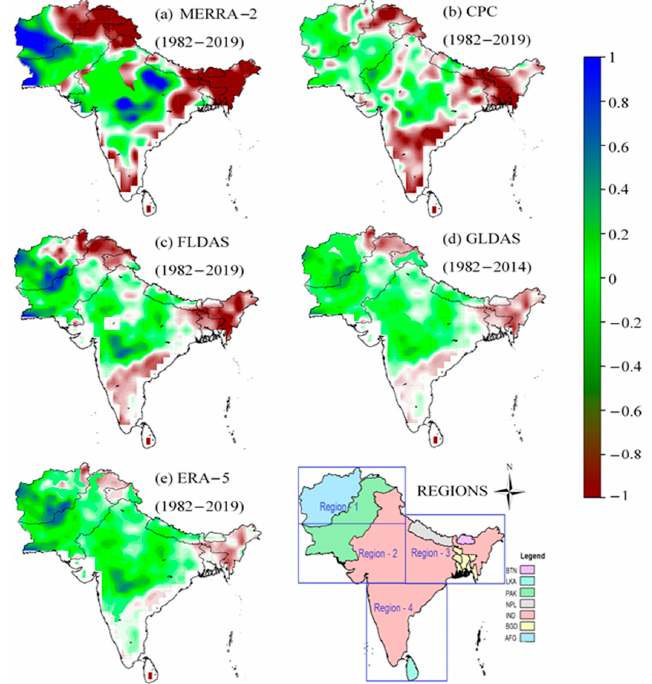
Figure 2. ( a – e ) The spatial patterns of different standardized soil moisture index (SSMI) over South Asia. These patterns have been scaled in the form of ±1, hence temporal assessment indicates the genuine magnitude (Figure 4) of SSMI, where spatial patterns have values near ±1. Remote Sens. 2021 , 13 , x FOR PEER REVIEW